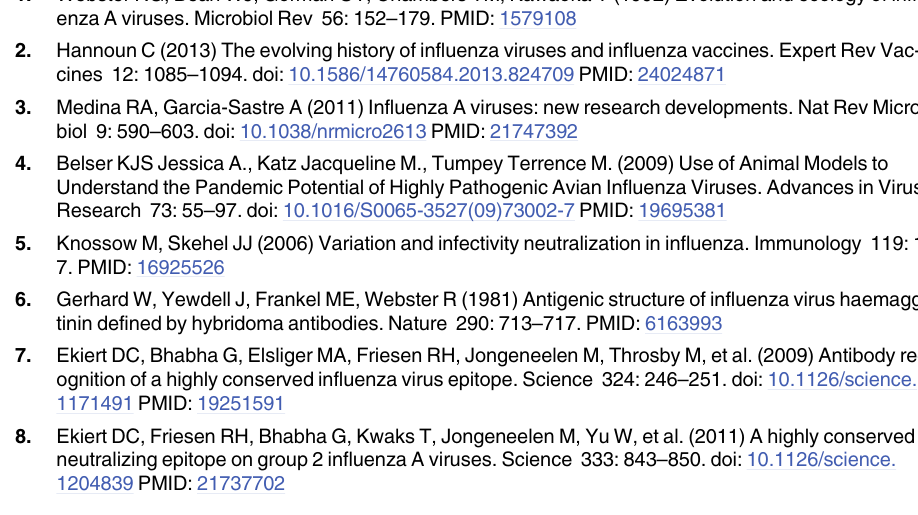
S2 Table. Summarizes p-values of various group comparisons of T-cell responses. Statistical analysis was performed as described in the material and methods section. TVV = Trivalent Vir- osomal Vaccine. MM = Matrix-M. TP = Total peptide pool. nd = no statistical analyses per-